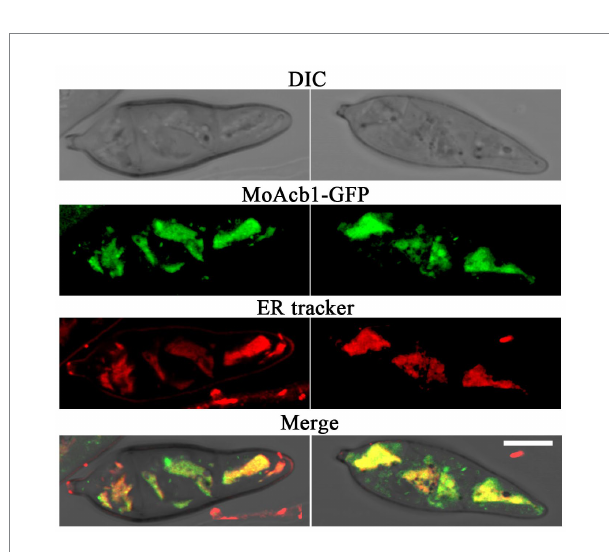
FIGURE 5 Subcellular localization of MoAcb1. Colocalization of MoAcb1-GFP and ER tracker Red in the conidia. Bar, 5 μ